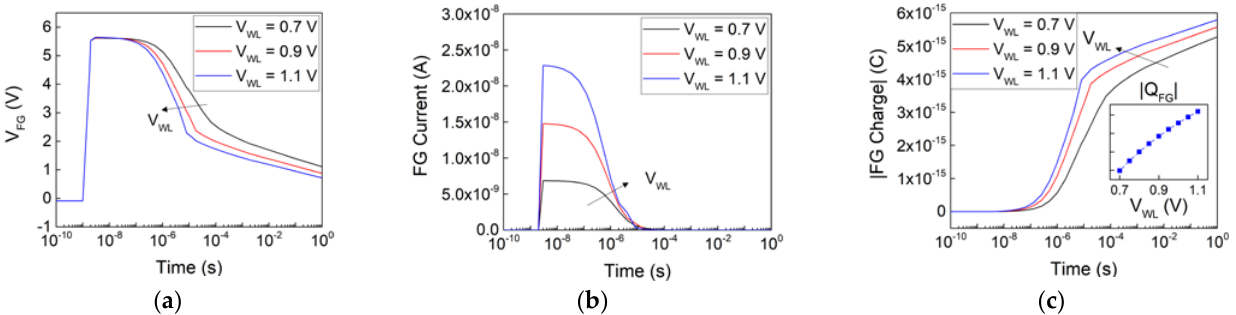
Figure 8. TCAD simulations of the ( a ) FG potential, ( b ) FG current, ( c ) charge injected in the FG, as function of time during a 1 s long program pulse with the pulse amplitude as a parameter. The sub-linearity of the FG charge with V WL is highlighted in the inset of ( c ).